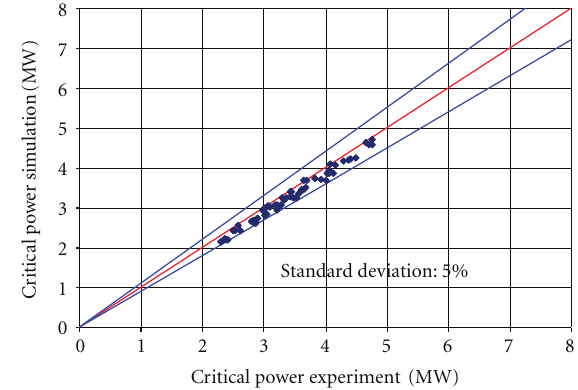
Figure 22: Measured and simulated critical power values for assem- bly A13.